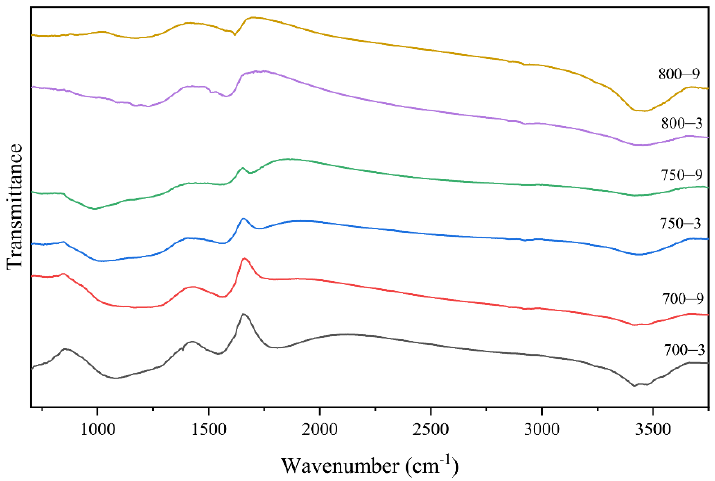
Figure 5. IR spectra of the samples.